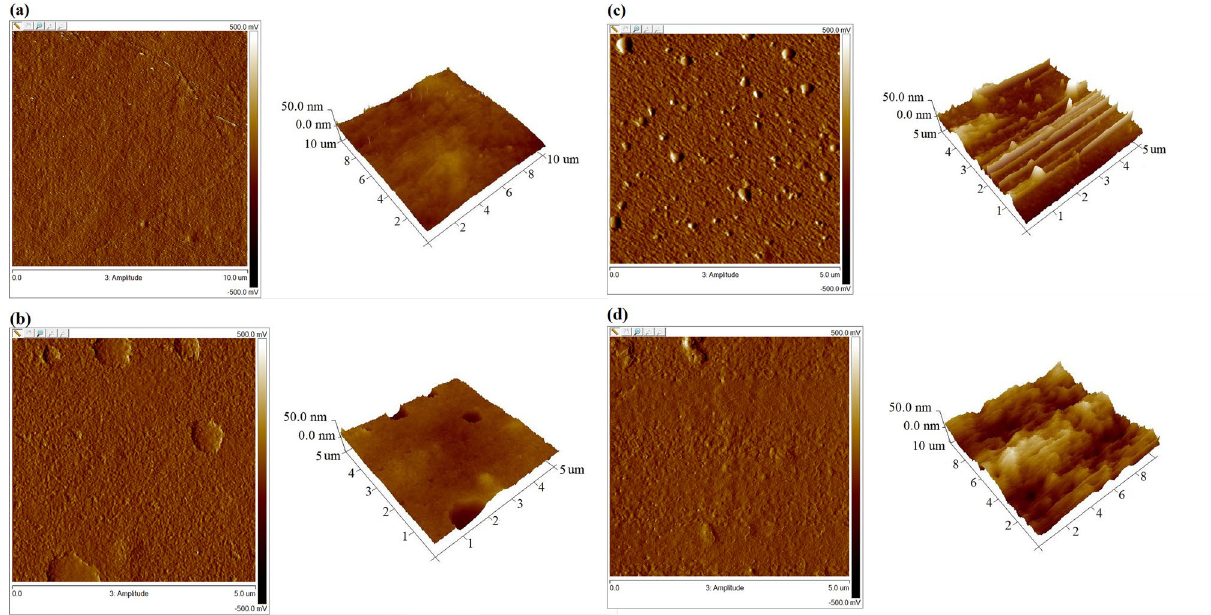
Figure 4. AFM images of ( a ) chitosan, ( b ) 1CBD-CS, ( c ) 5CBD-CS, and ( d ) 10CBD-CS films). CBD-CS— cannabidiol-chitosan-based films, where 1, 5, 10CBD-CS corresponds to the weight ratio of 1, 5 or 10% of cannabidiol oil (CBD) to chitosan (CS).